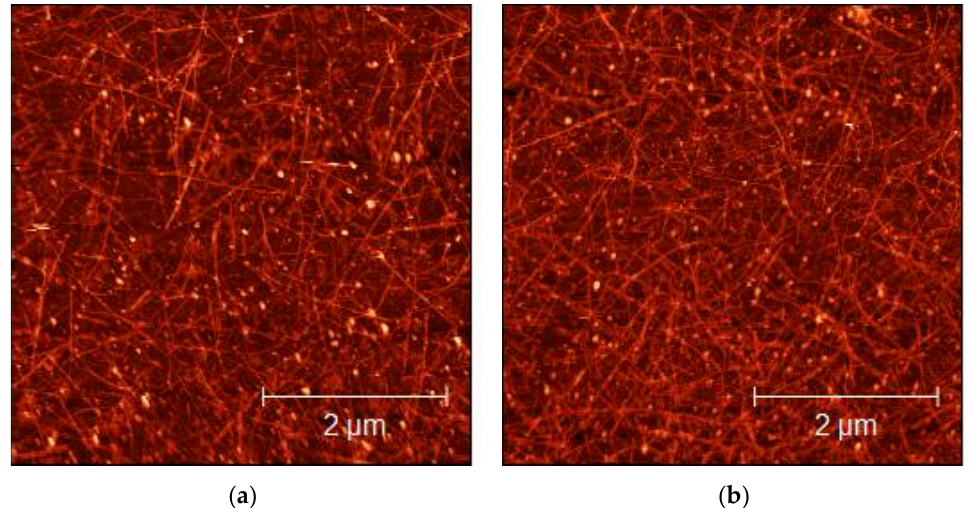
Figure 4. AFM micrograph of 1:15 diluted CMC-SWCNT-sprayed dispersions on glass substrates: ( a ) 10 layers; ( b ) 50 layers.